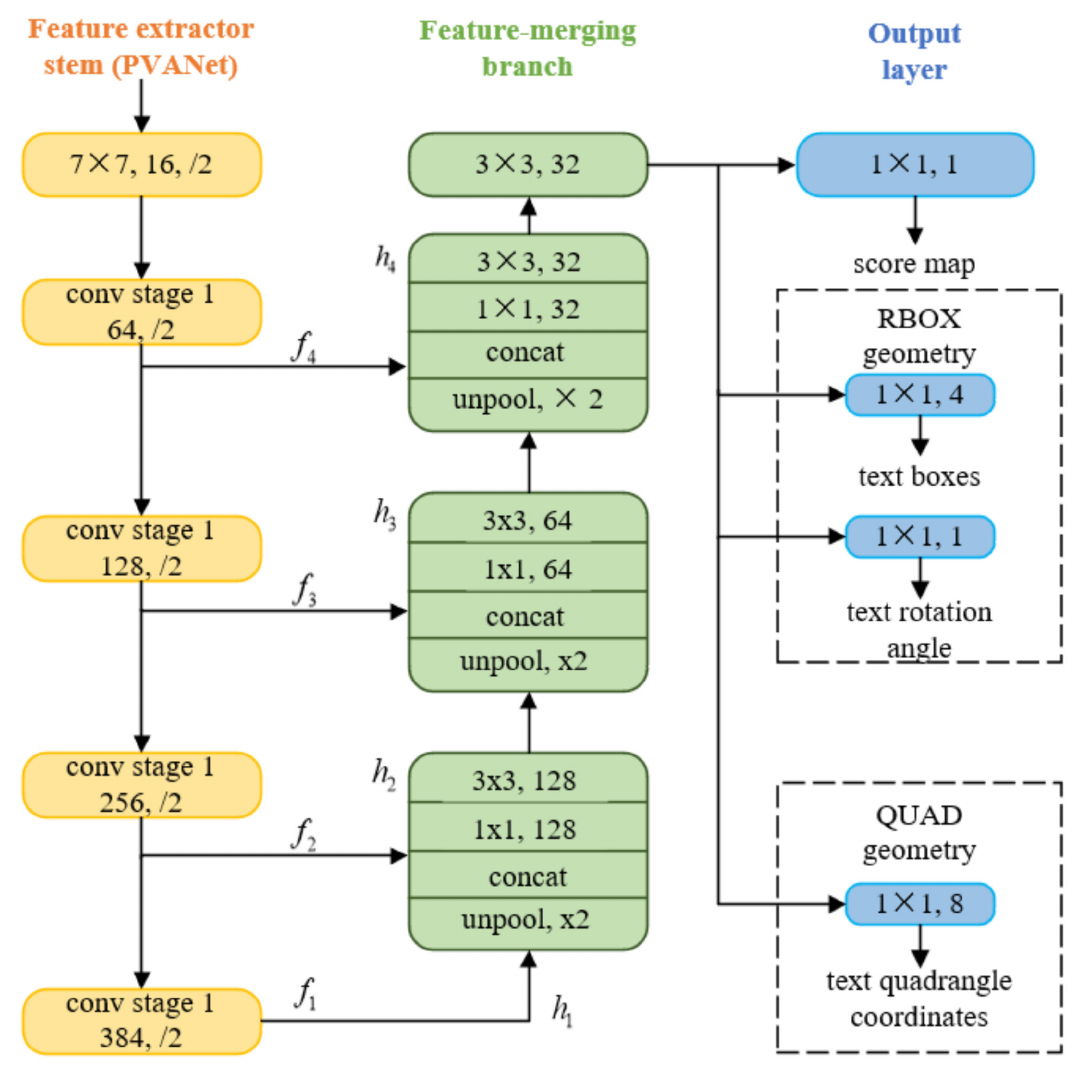
Figure 2. EAST algorithm